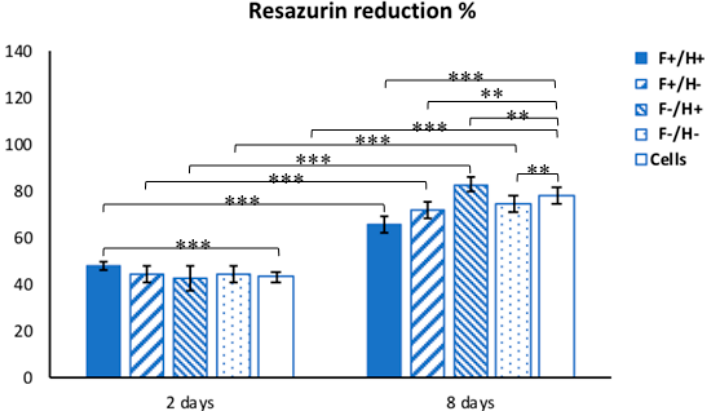
Figure 9. Bar graph showing the metabolic activity (as resazurin reduction percentage, given as average ± standard deviation) of hDFs in contact with the Dexa-loaded and -unloaded fiber/hydrogel composites for 8 days. ** p < 0.001, *** p < 0.0001.